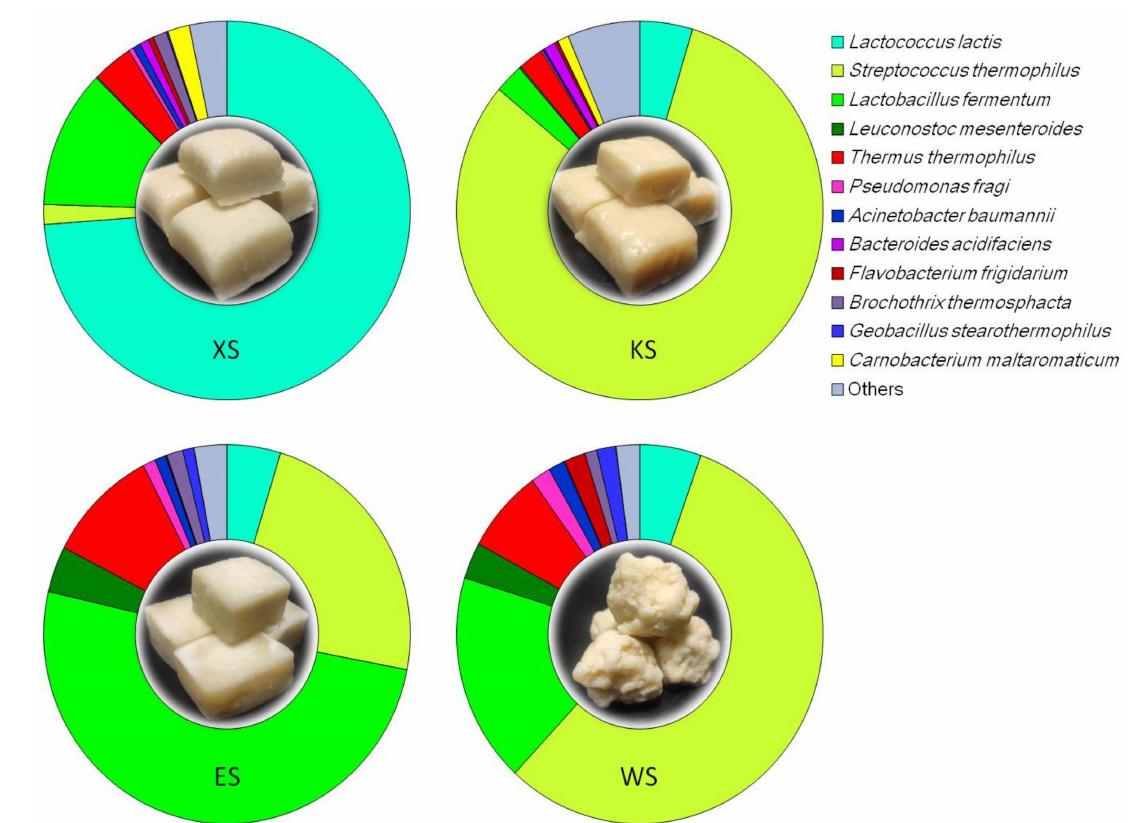
Figure 1. Dominant bacterial species with a relative abundance greater than 1% in different cheese samples. The sizes of the different-coloured areas in the rings represent the relative abundance of different dominant species. Cheese samples are shown in the middle of the rings. ES, cheese sample from the Ordos grassland; XS, cheese sample from the Xilingol grassland; KS, cheese sample from the Horqin grassland; WS, cheese sample from the Ulanqab